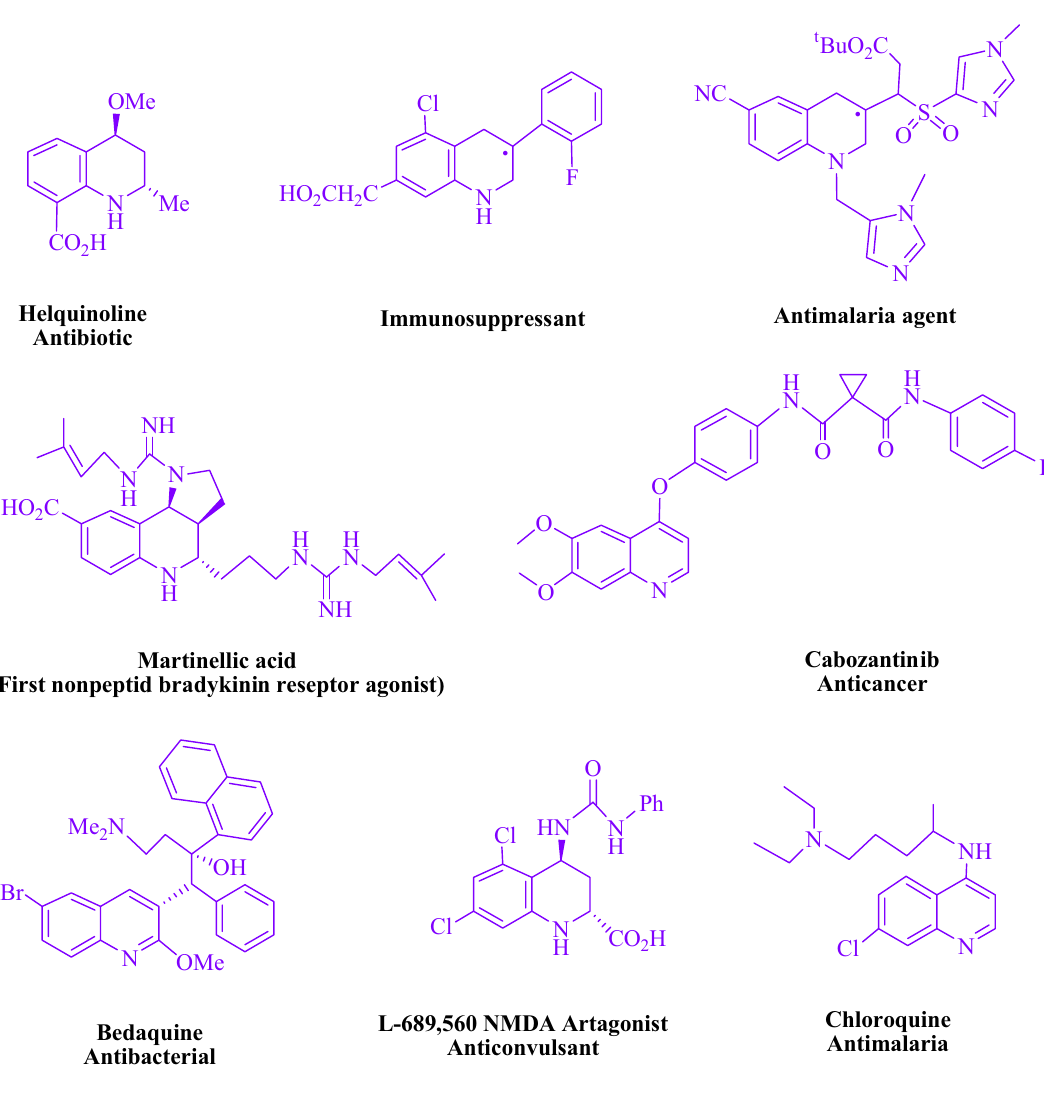
Figure 1. Compounds with biologically active quinolines